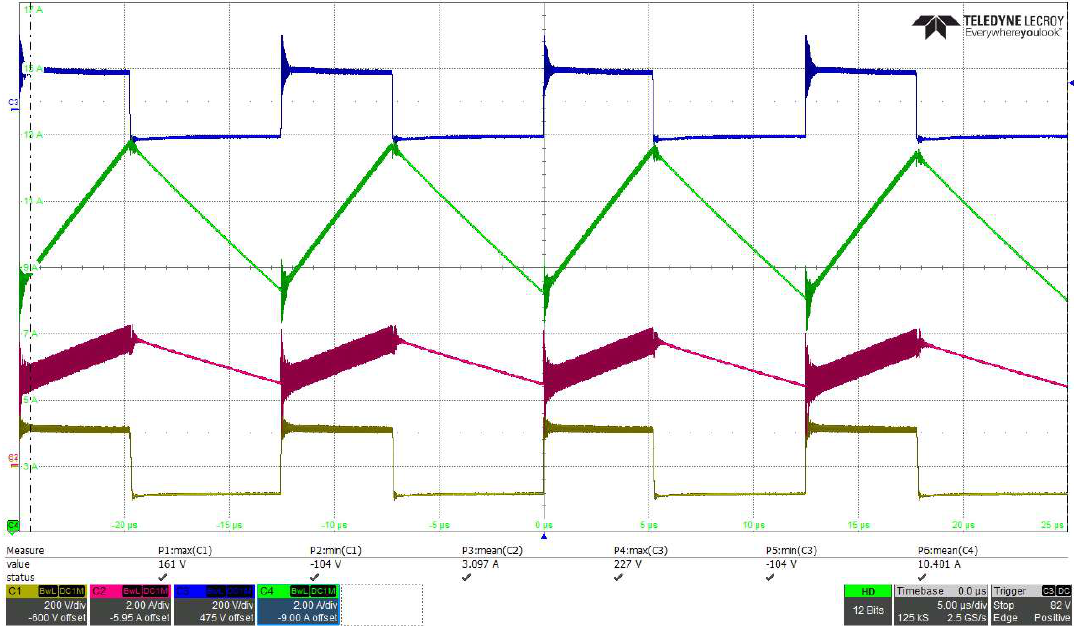
Figure 28. Experimental BHSC waveforms for step-down operation at V H = 300 V, V L = 80 V, and I L = 10 A (controlled). C1: V L2 ; C2: i L2 ; C3: V L1 ; C4: i L1 .